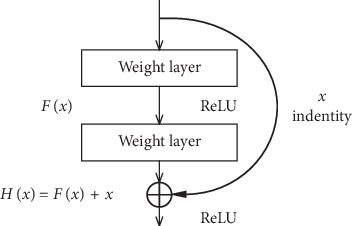
Residual element.